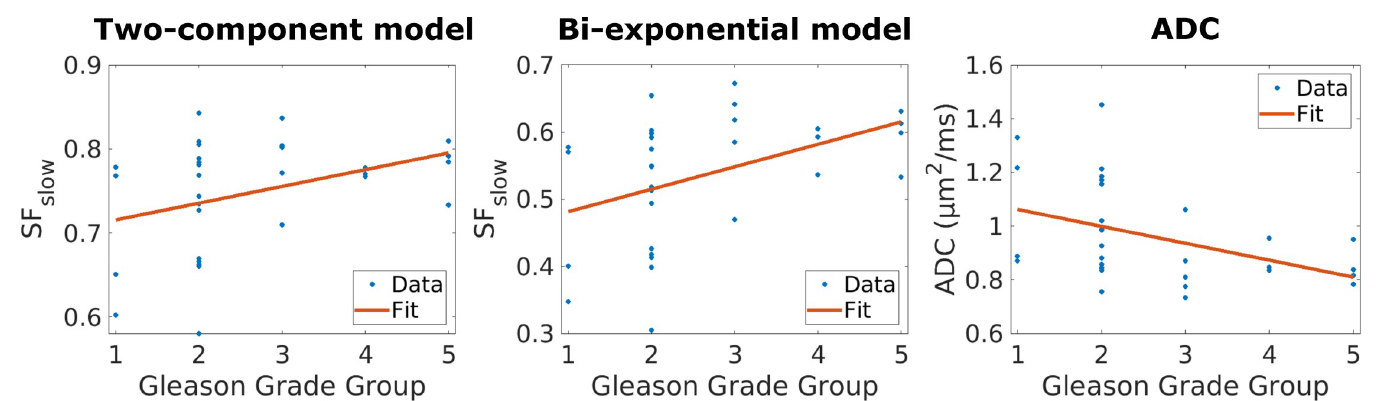
Fig 5. Mean tumor ROI values plotted as a function of Gleason Grade Group (blue dots) for SF slow (from the two-component and bi-exponential models) and ADC. The red line represents the least-square fit to the data.